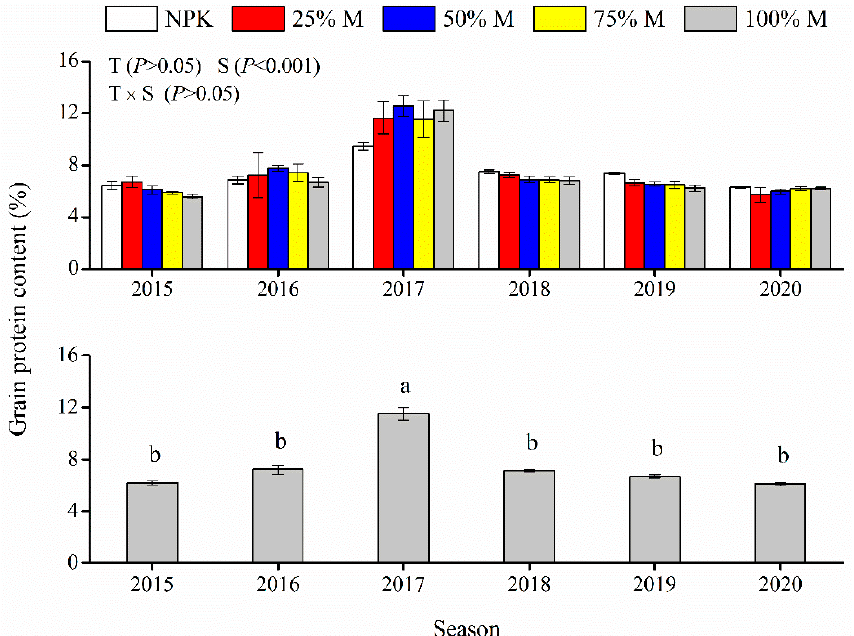
Figure 6. Maize grain protein content under different treatments of winter wheat–summer maize cropping system during 2014–2020. Bars represent standard error. Different letters above bars are significantly different between treatments or years at P < 0.05. Table 2. Effect of year and treatment on nitrogen uptake efficiency (NPE), nitrogen use efficiency (NUE), phosphorus uptake efficiency (PPE) and phosphorus use efficiency (PUE), of winter wheat– summer maize cropping system during